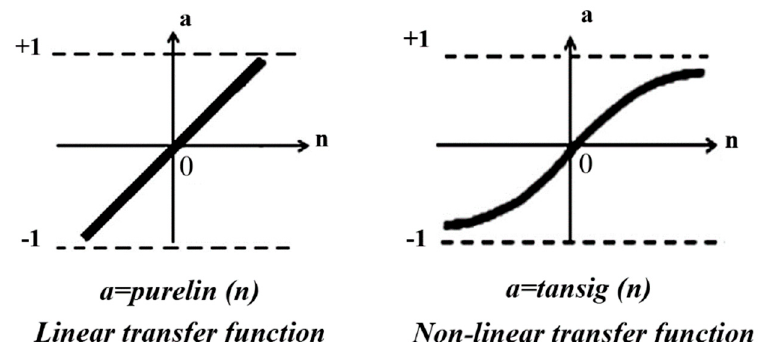
Figure 8. Transfer function.